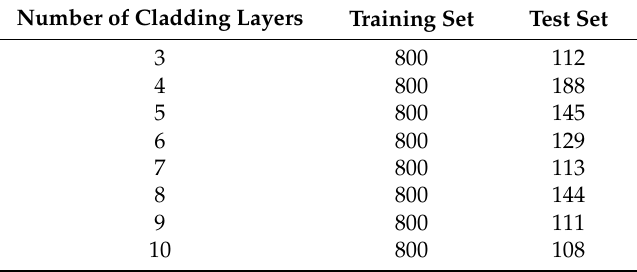
Table 8. Number of data groups within training and test sets.